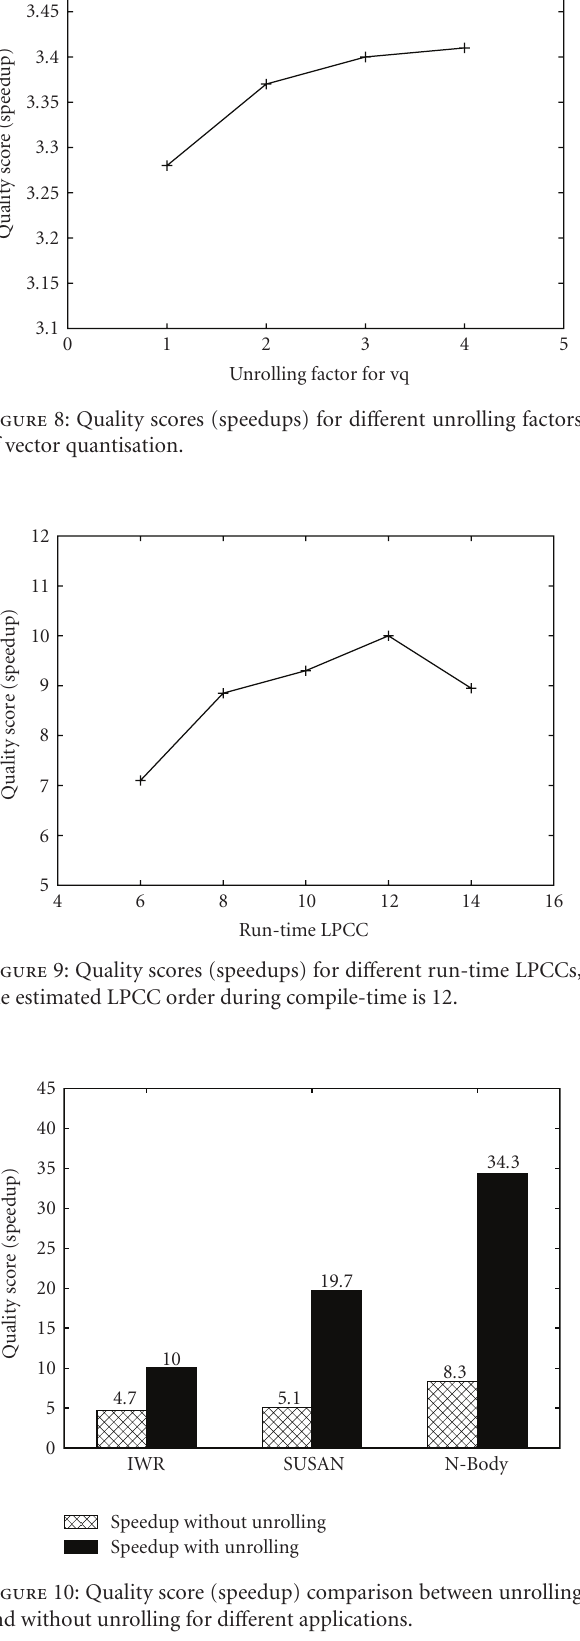
Table 4: FPGA resources and operating frequency for IWR, SUSAN, and